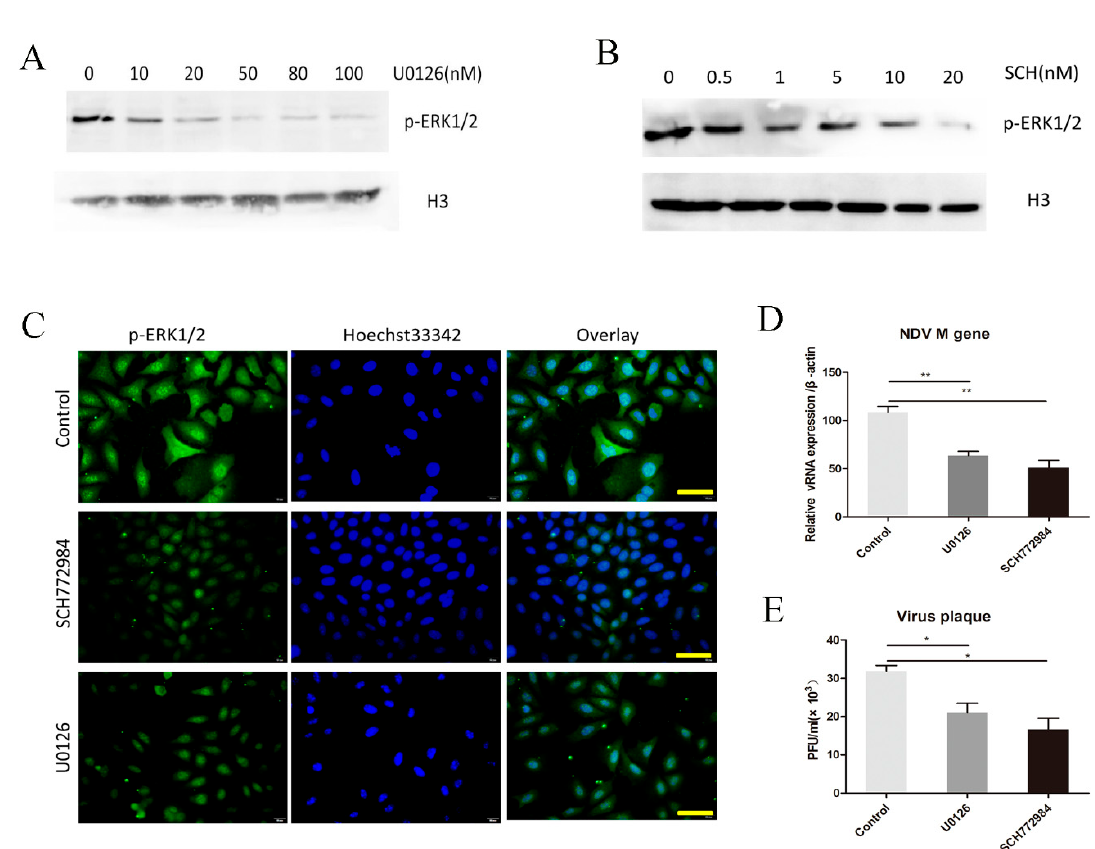
Figure 2. The extracellular signal-regulated kinase (ERK)1/2 inhibitors, U0126 and SCH772984, reduce NDV replication in HeLa cells. Cells were treated with various concentrations of ( A ) U0126 and ( B ) SCH772984. Lysates from treated cells were analyzed by Western blotting with the p-ERK1/2 antibody and H3 histone as a reference. ( C ) After treatment with 10 µM of the ERIK1/2 inhibitors, the expression of p-ERK1/2 protein in HeLa cells was detected using immunofluorescence (400×), bar = 50 µm. ( D ) HeLa cells were infected with NDV F48E9 (1 MOI) for 24 h and the quantitative reverse transcription polymerase chain reaction was used to measure viral RNA in cell lysates in control cells and cells treated with either 100 nM U0126 or 10 nM SCH772984, while ( E ) viral plaque formation was assessed to measure the number of viral particles in the supernatants. Data are presented as means ± SD of three independent experiments. * p < 0.05; and ** p < 0.01.